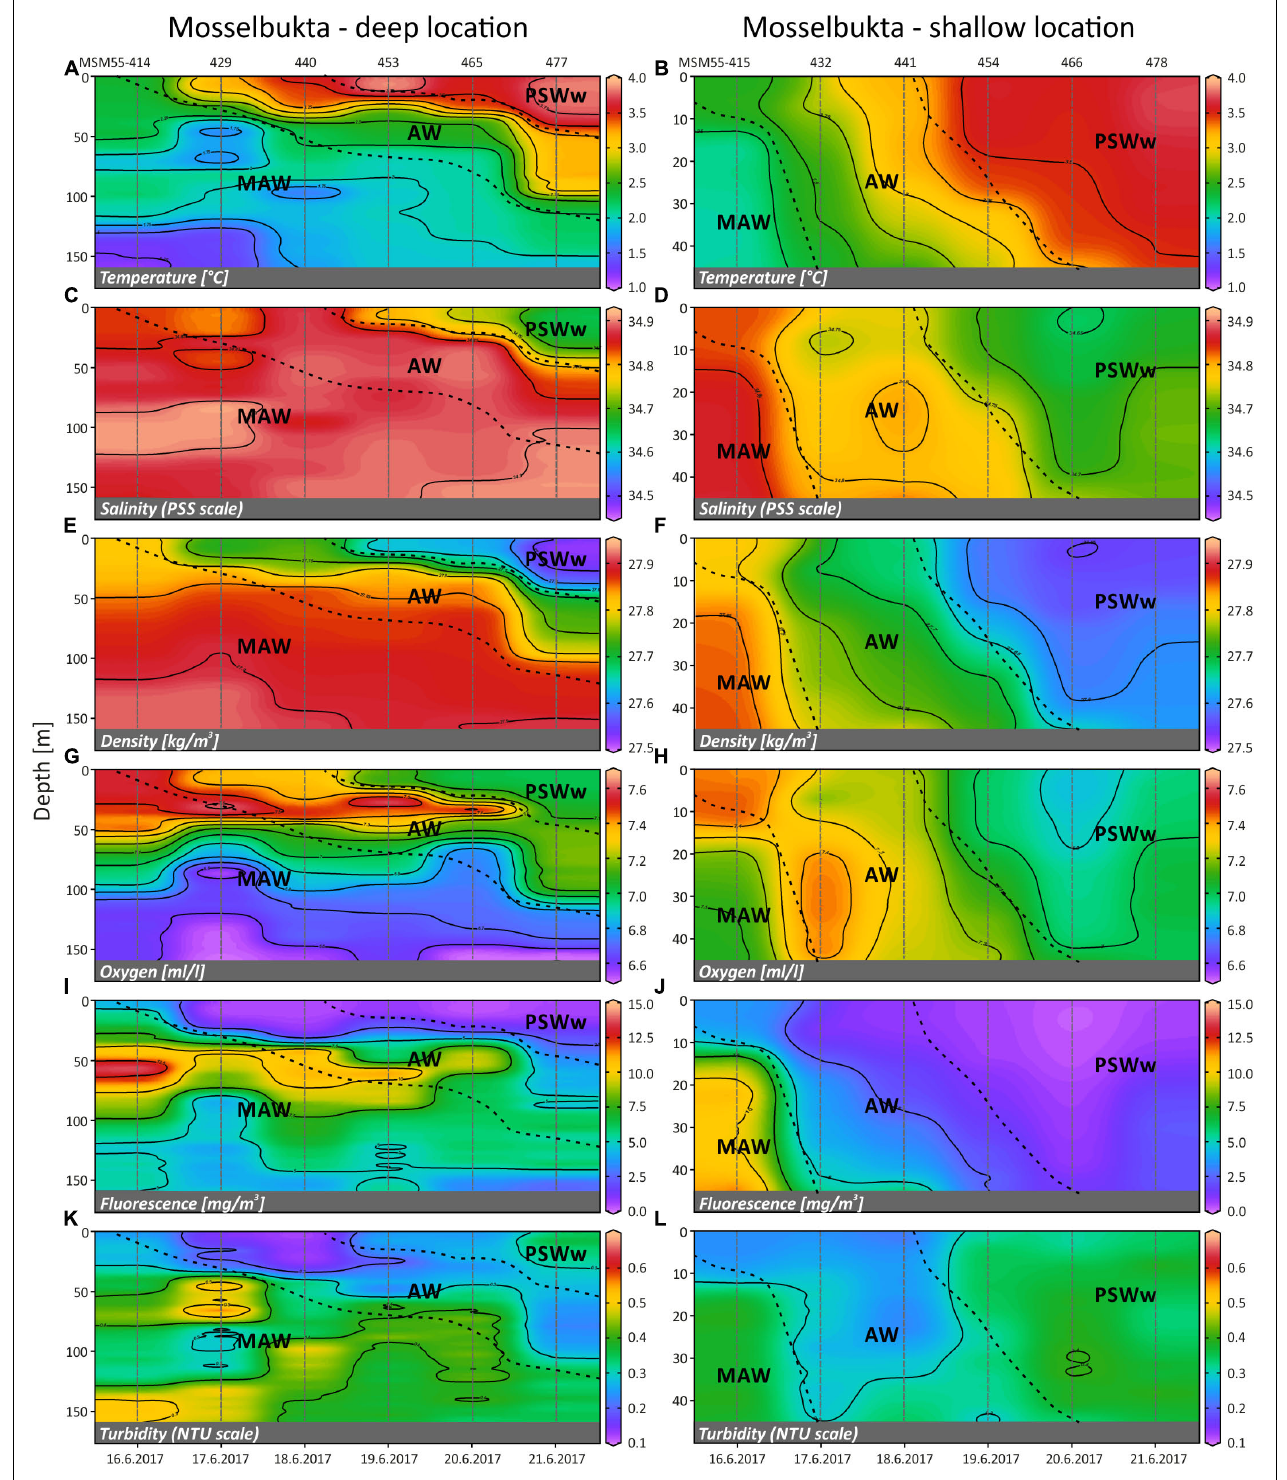
FIGURE 8 | Temperature (A,B) , salinity (C,D) , density (sigma-theta) (E,F) , dissolved oxygen (G,H) , fluorescence (I,J) and turbidity (K,L) of the deep (left) and shallow (right) CTD localities in Mosselbukta, plotted against time and water depth (plots generated in Ocean Data View). AW, Atlantic Water from the south; MAW, Modified Atlantic Water from the Arctic Ocean; PSWw, warm Polar Surface